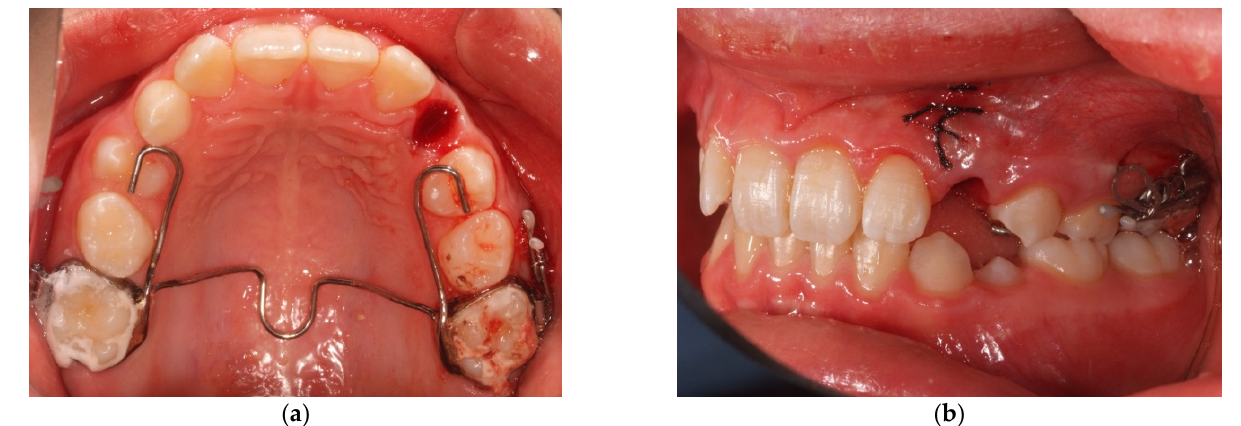
Figure 2. Anchorage through a transpalatal bar ( a ) and a vestibular arm ( b